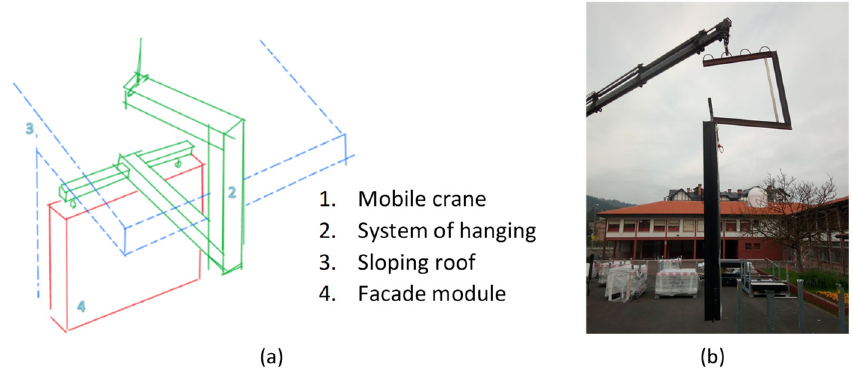
Figure 15. ( a ) Fastening system meeting with sloping roof; ( b ) designed tooling.